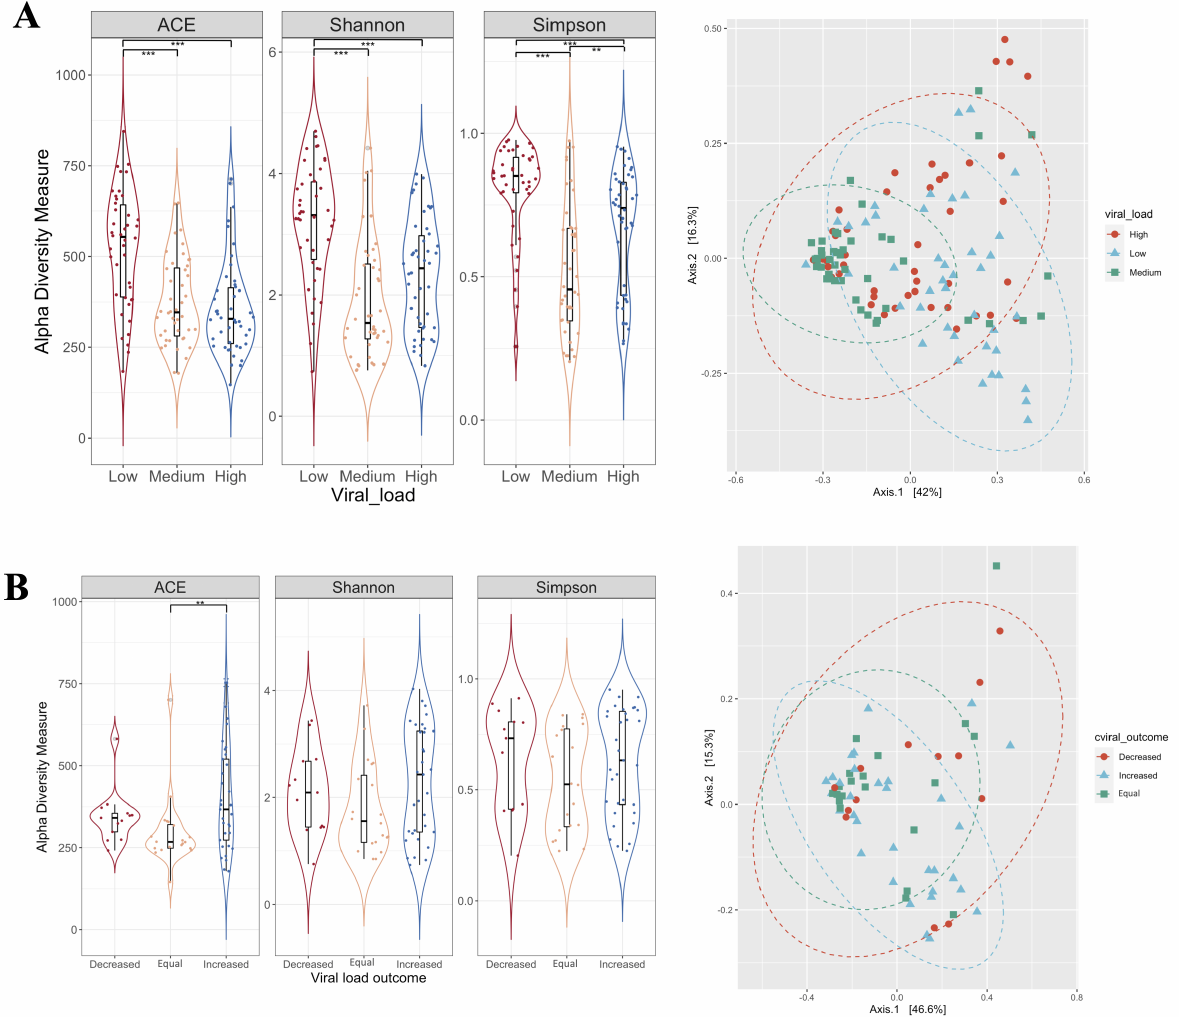
Figure 2. Alpha and beta diversity between groups. ( A ) Boxplot of diversity indexes and NMDS plot regarding viral load. ( B ) Boxplot of diversity indexes and NMDS plot regarding viral load outcome. Significant differences between the study groups were evaluated using a Kruskal–Wallis test ** p = 0.001–0.01, and *** p <